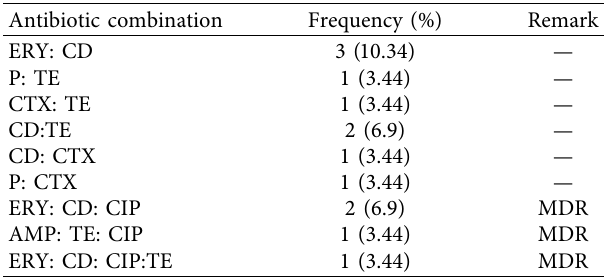
Table 4: Multidrug resistance (MDR) profile of GBS isolates from pregnant women at JJUSSHYRH and KGH in Jigjiga city, Southeast Ethiopia, March–May, 2021. Antibiotic